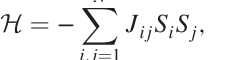
FIG. 1. Example Chimera graph with k 2 ¼ 16 blocks of 8 qubits (black dots). This means the system has N ¼ 128 qubits and an effective linear size L ¼ nectivity between the spins within each block effectively renders the model quasi – two dimensional. Note that the graph is not